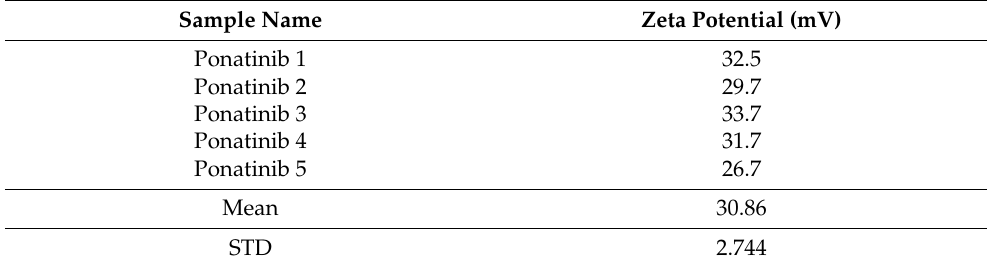
Table 2. Ponatinib drug surface